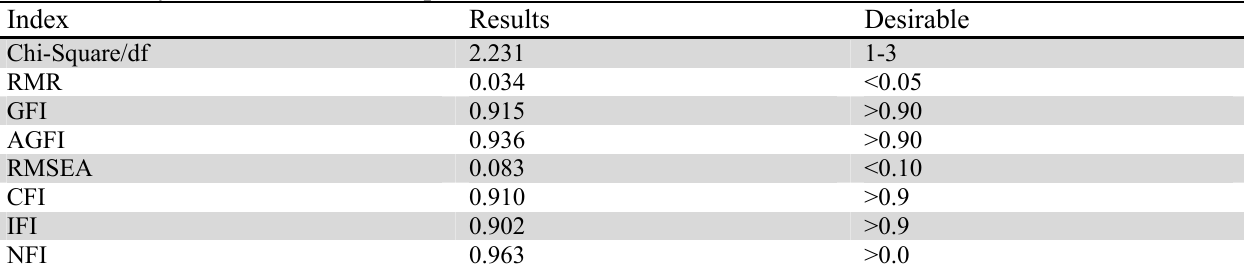
The summary of statistics SEM implementation